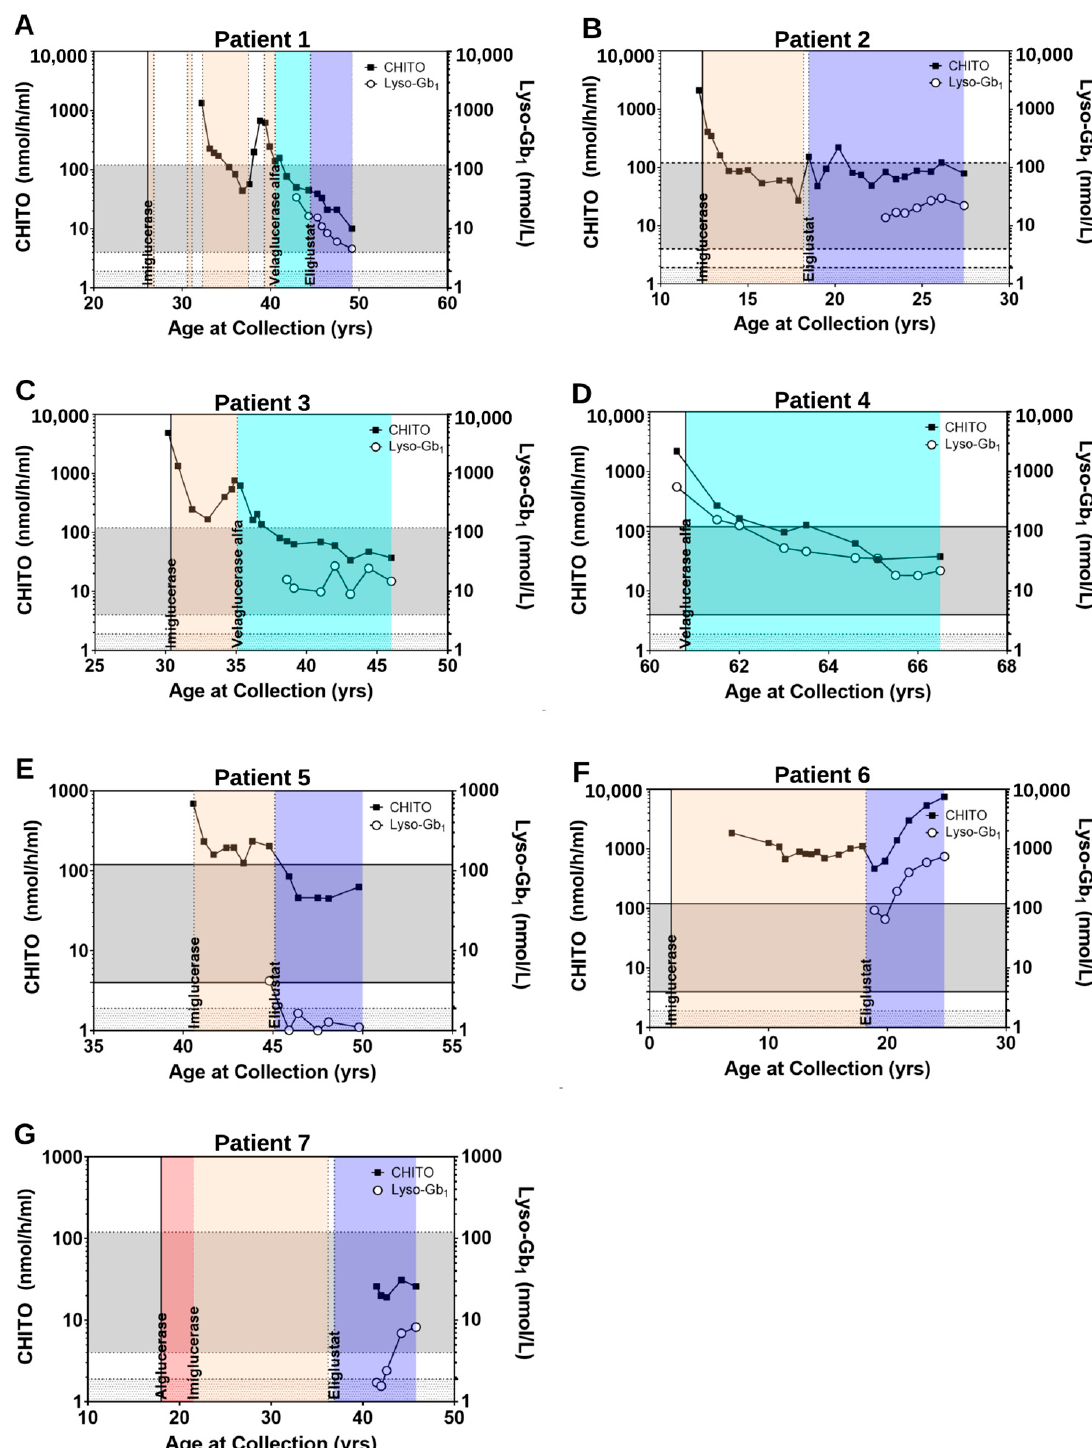
Figure 2. Biomarker values in ( A – G ) Patients 1–7, respectively. Vertical solid line denotes start of treatment and vertical dashed lines denotes either treatment switch or stop in treatment. Tan shading denotes treatment with imiglucerase, blue shading denotes treatment with velaglucerase alfa, purple shading denotes treatment with eliglustat, and red shading denotes treatment with al- glucerase.